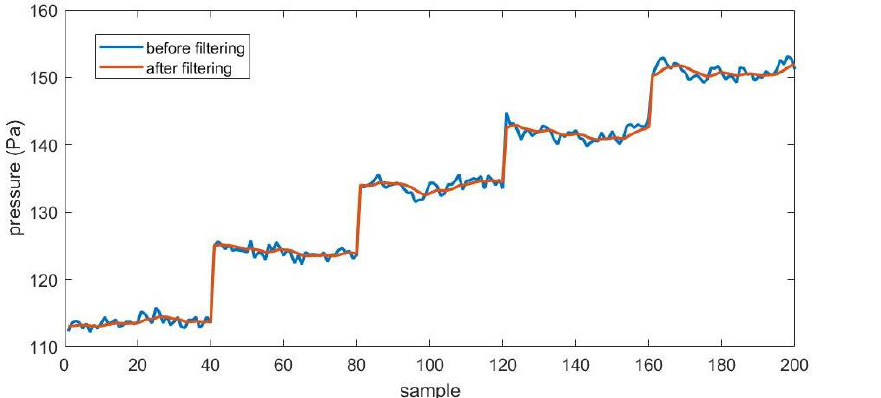
Figure 13. Comparison of the fluctuations of some experimental data before and after